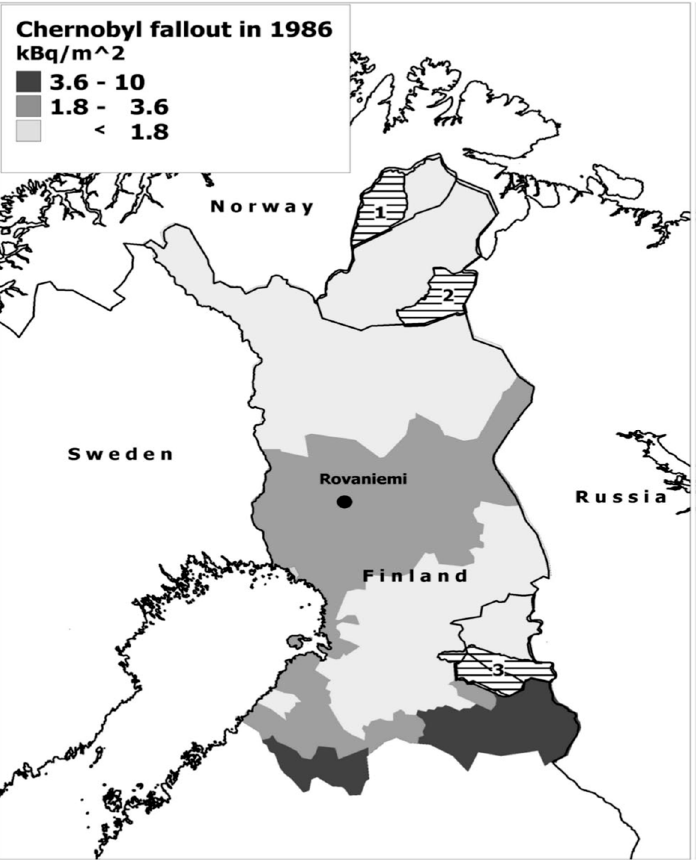
Figure 2. Chernobyl 137 Cs fallout in Northern Finland. The reindeer-herding cooperatives: (1) Paistunturi, (2) Ivalo ja (3) Halla. The borders of the municipalities of Utsjoki, Inari, Suomussalmi and Hyrynsalmi are also shown [28].